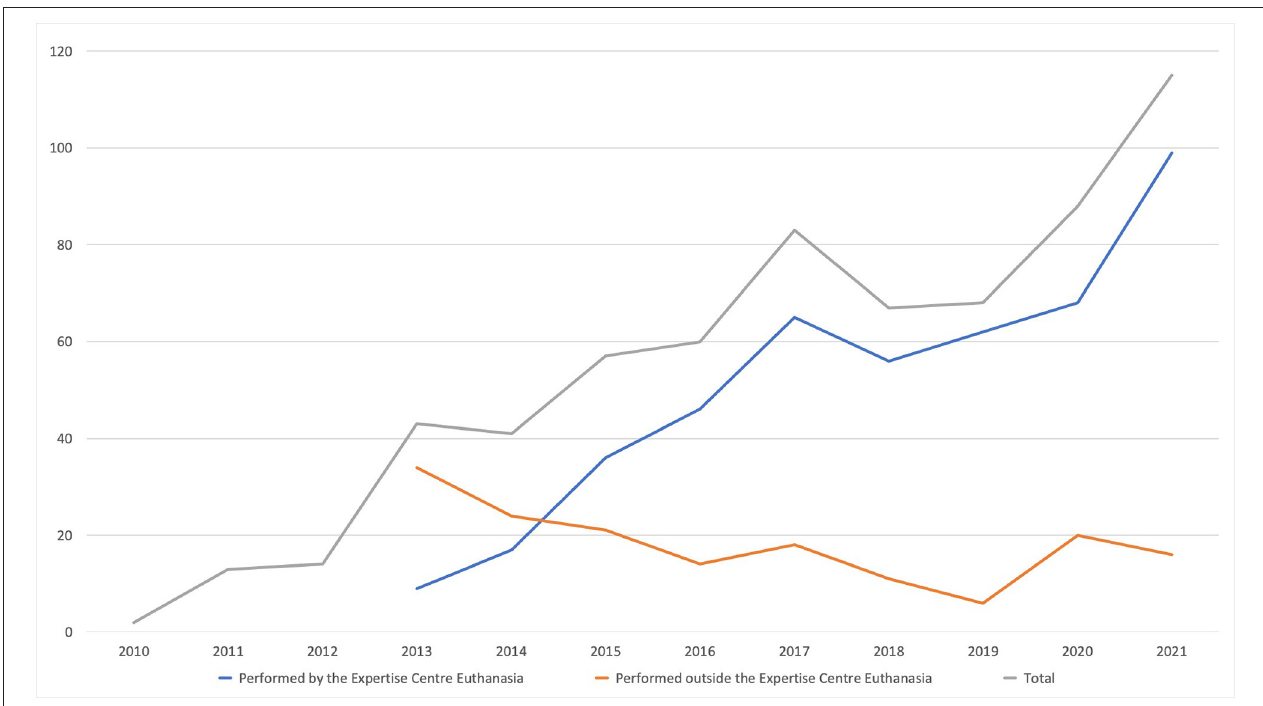
FIGURE 1 | Number of physician-assisted deaths performed inside and outside of the Euthanasia Expertise-Center.